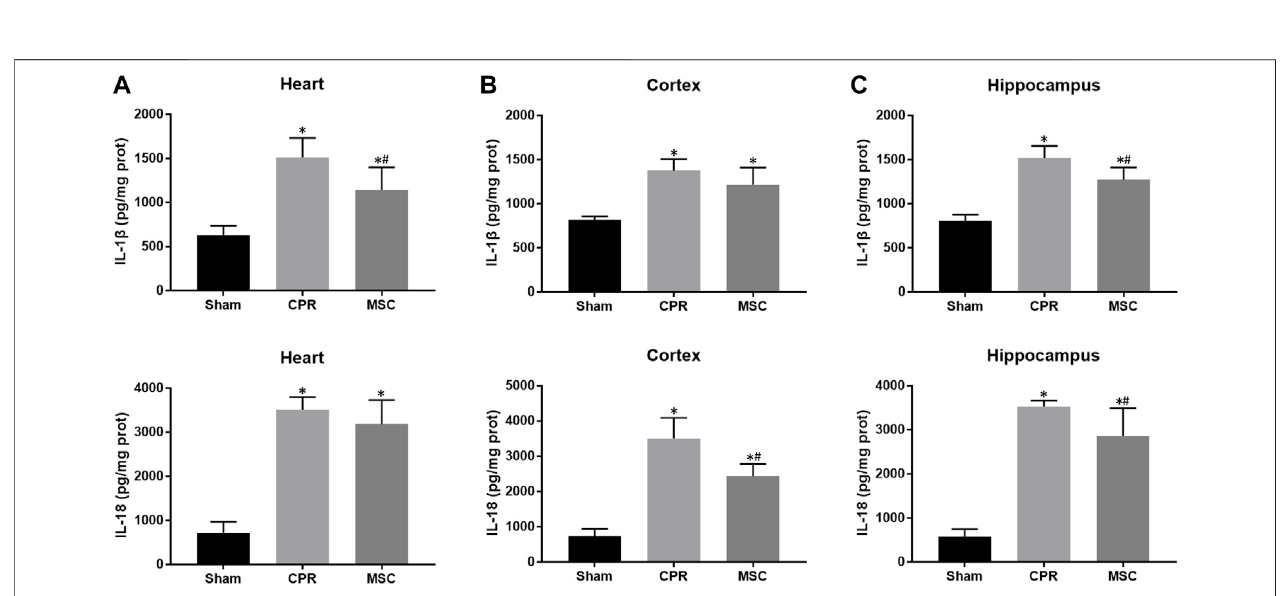
FIGURE 7 | Contents of proin fl ammatory cytokines (A) – (C) The contents of IL-1 β and IL-18 in the heart, cortex and hippocampus. IL-1 β , interleukin-1 β ; IL-18, interleukin-18; CPR, cardiopulmonary resuscitation; MSC, mesenchymal stem cell. * p < 0.05 versus sham group; # p < 0.05 versus CPR group.